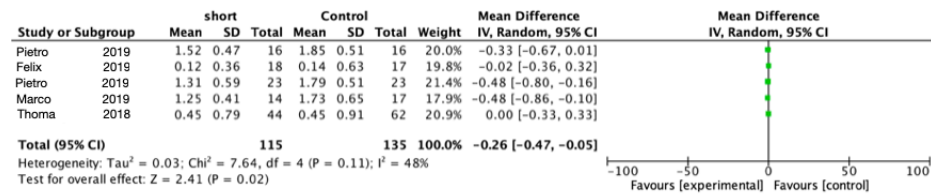
Figure 5. Comparison of marginal bone loss using short implants vs. longer implants with elevation of the sinus floor after 1 year in function via a meta-analysis.